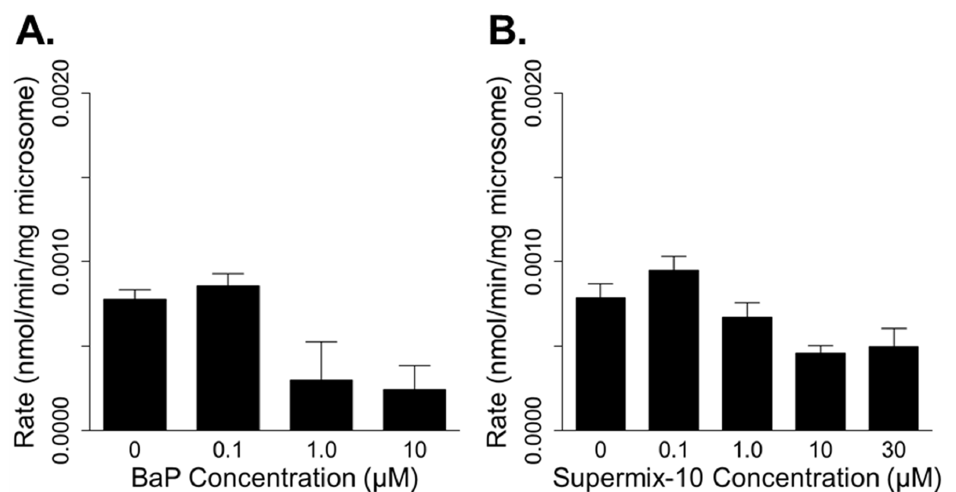
Figure 4. Rates of dibenzo[def,p]chrysene (DBC) metabolism (0.17 µ M) in human hepatic microsomes co-incubated with increasing concentrations of benzo[a]pyrene (BaP; ( A )) or Supermix-10 ( B ).